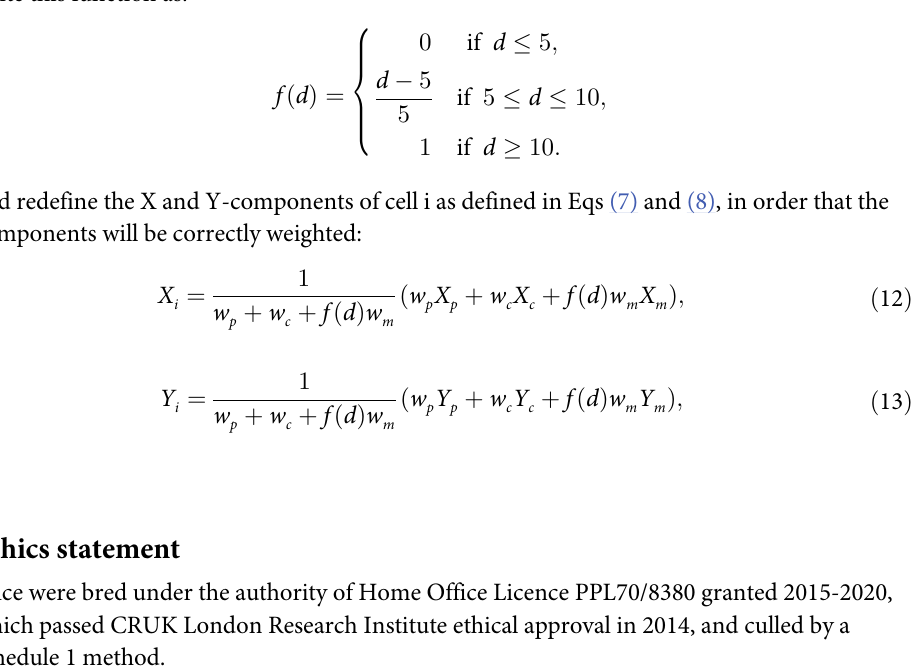
S1 Fig. Metrics characterizing matrix. (A) Schematic of patterns with different values of long-range alignment (LRA) and short-range alignment (SRA). (B) Schematic demonstrating different values of high-density matrix (HDM). (C) Schematic showing examples of low and high curvature (Curv). (D) Schematic examples of patterns with different fractal dimension (Frac), including a Hilbert curve as an example of a pattern with a fractal dimension of two. from https://commons.wikimedia.org/wiki/File:Hilbert_curve.svg, licensed under Creative Commons. S2 Fig. Analyzing where fibroblasts deposit fibronectin. Two examples exploring where fibroblasts produce fibronectin. Fibroblasts were plated, and then began to spread and com- mence migration. They were then fixed and stained for F-actin (bottom left panels) to reveal their dominant protrusion and hence direction of migration, fibronectin (top left panels) and paxillin to reveal points of substrate attachment (top right panels). A composite image is shown in the bottom right panels. Scale bar represents 10 μm . S3 Fig. Emergent in silico matrix patterns from cell-cell interactions. (A) Aligned matrix generated with parameters η = 0, w = 0.03, w = 0. (B) Isotropic matrix generated with param- c m eters η = 0, w = 0, w = 0. Images from simulations showing fibroblasts (top) and correspond- c m ing matrix (bottom) over six days. Scale bar represents 100 μm . (C) The effect of increasing cell-cell guidance ( w ) on matrix organization for cells with low individual migratory c